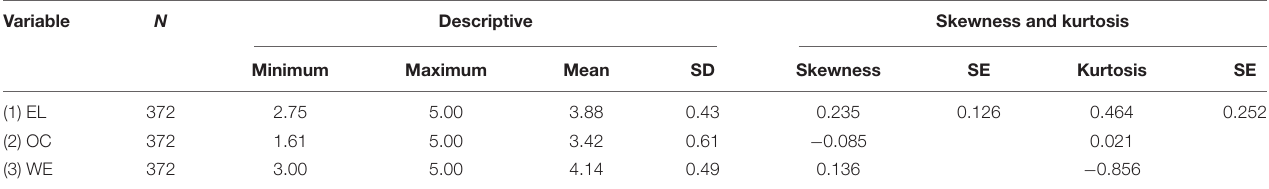
TABLE 1 | Descriptive statistics and normality assumption.